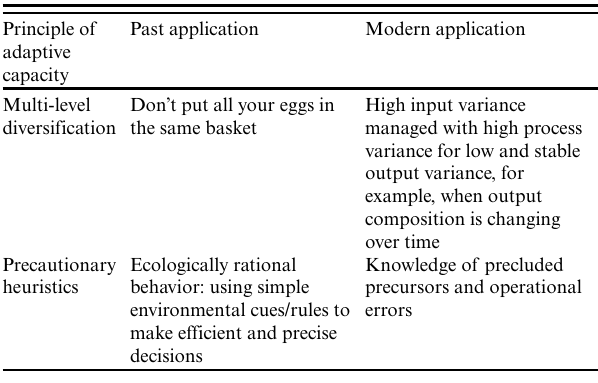
Table 1 . Past and present applications of the principles of adaptive